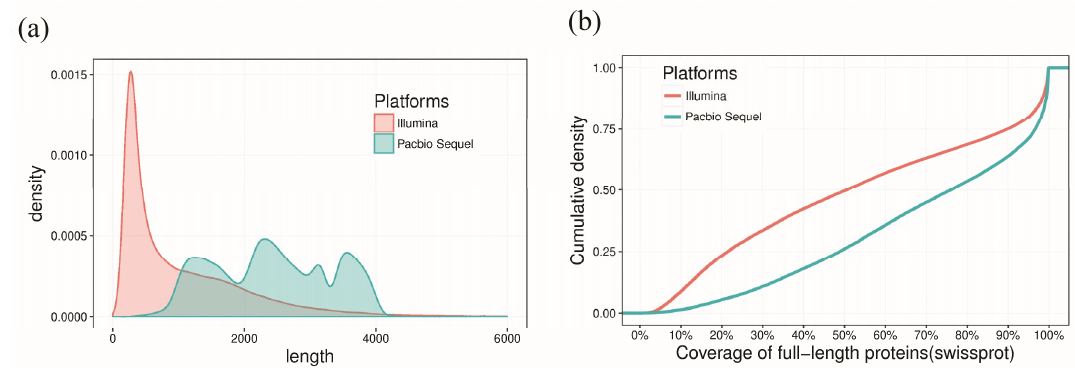
Figure 2. Mapping statistics for corrected long reads from PacBio sequencing and de novo assembled contigs from Illumina sequencing. ( a ) Length distribution of Iso-Seq consensus transcripts and de novo–assembled contigs from Illumina sequencing. ( b ) Cumulative density plot showing the coverage of full-length proteins (Swiss-Prot) for transcripts identified by di ff erent sequencing platforms.